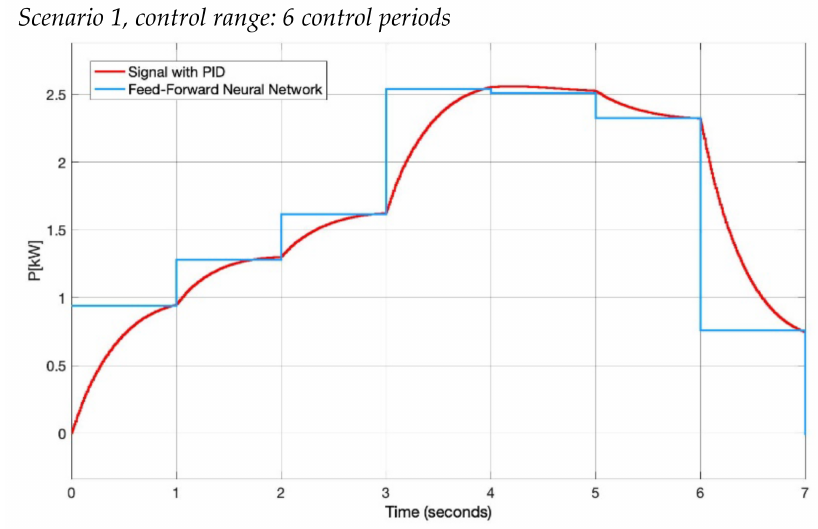
Figure 30. Control signal for BESS 2, p.f. = 1,